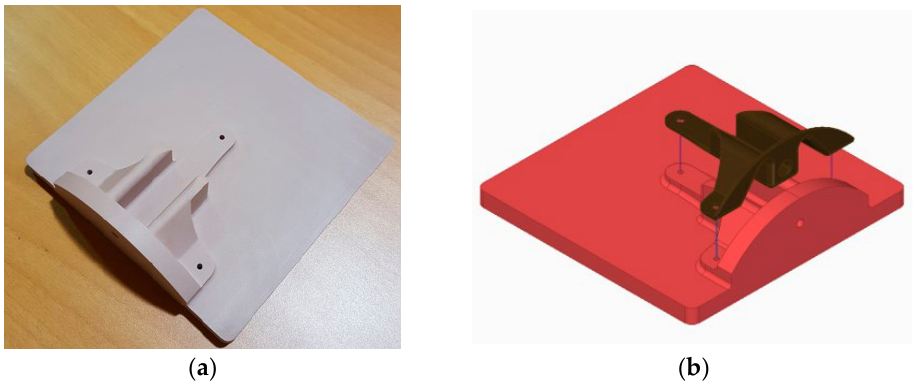
Figure 11. Mold for the wheel hub carrier bracket: ( a ) fabricated by SikaBlock and ( b ) Siemens NX12 simulation of mold/component.